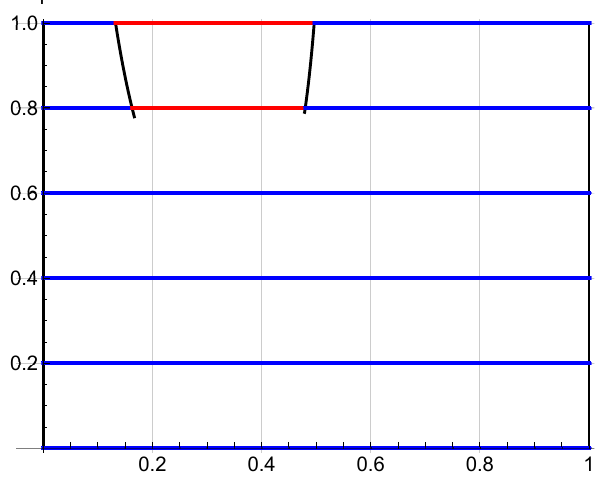
Figure 18. Potential distribution when there is a coupling between the first and third